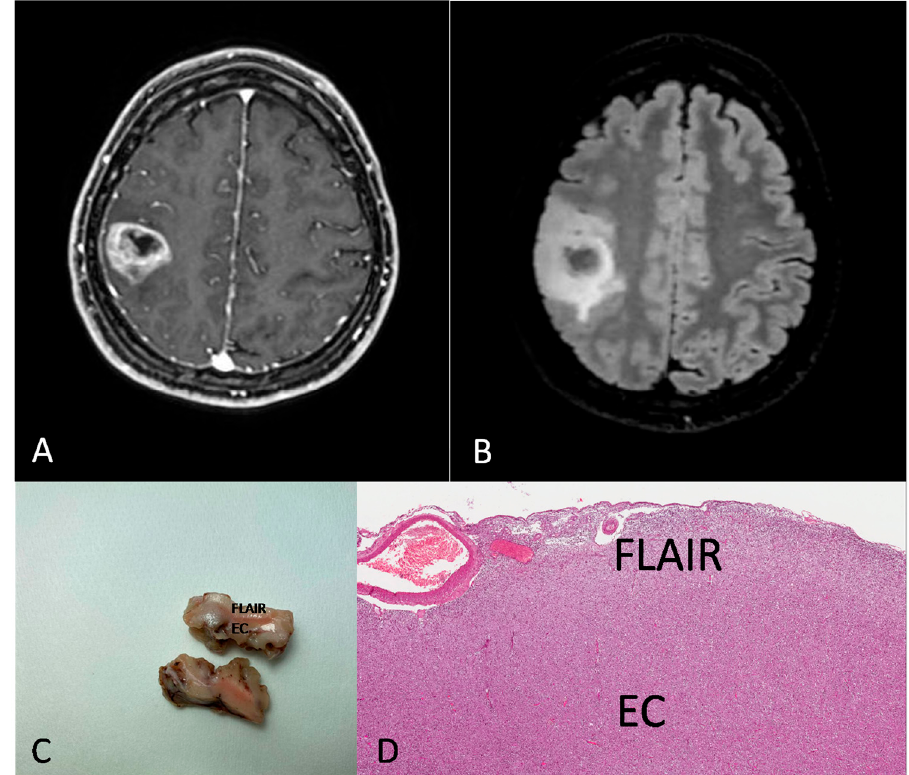
Figure 3. Preoperative MRI from a 31-year-old woman. ( A ) Axial section of a T1-weighted sequence with gadolinium showing a rolandic tumor with necrotic core and ring enhancement. ( B ) FLAIR sequence showing a hyperintensity beyond the EC. ( C , D ) Gross image ( C ) and histological medium magnification ( D ) showing both EC and FLAIR region from the excised mass (( D ) H&E; original magnification 50×).